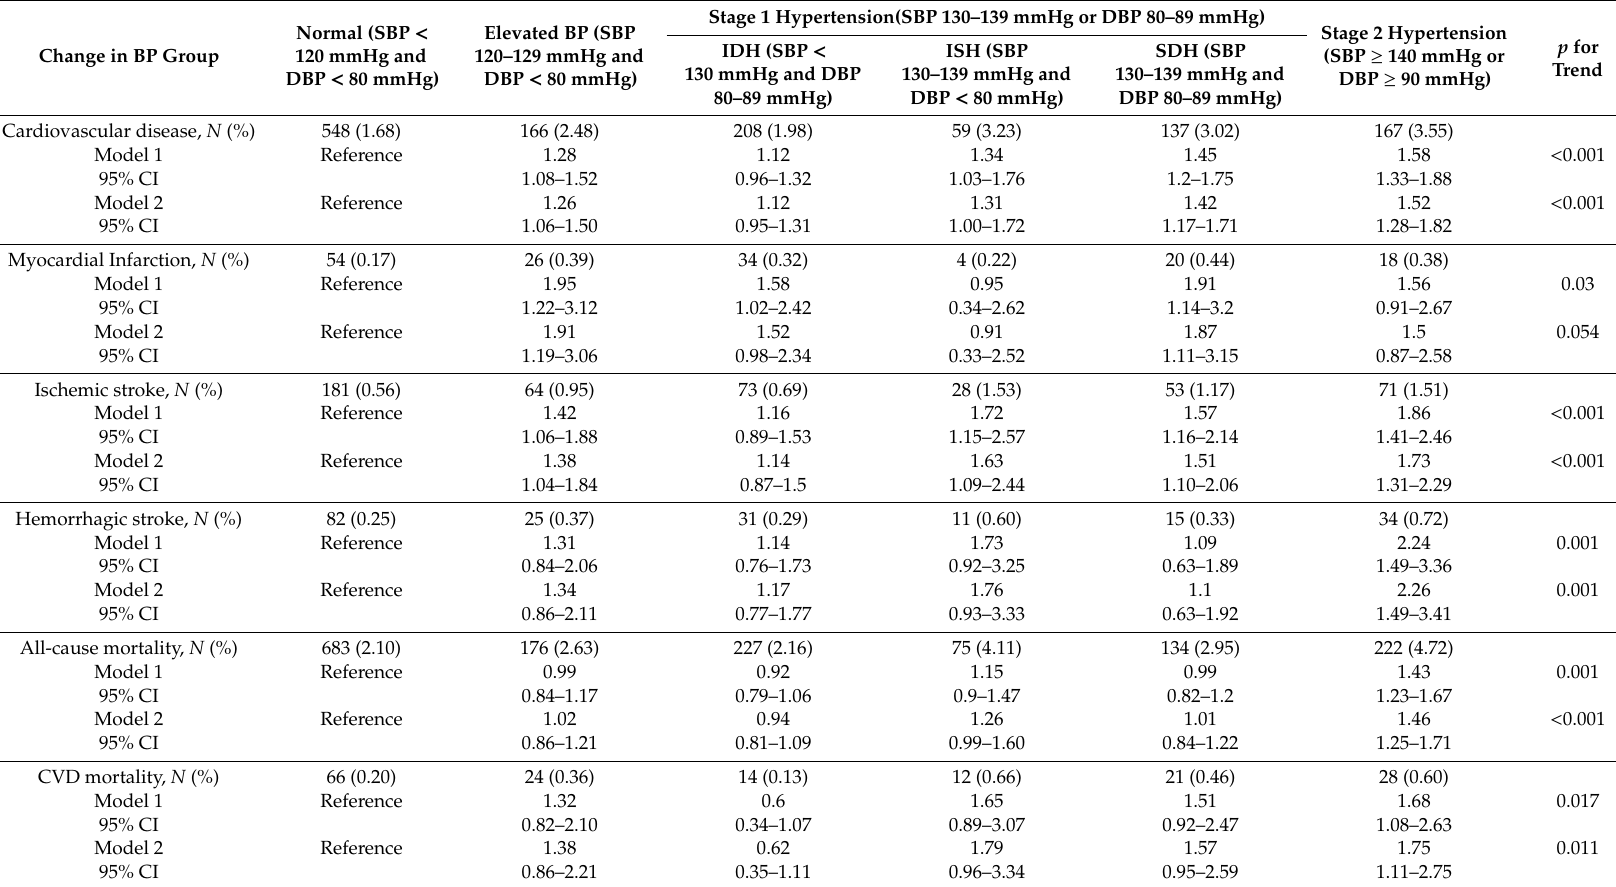
Table 3. Additional analysis of associations between change in blood pressure according to the 2017 ACC / AHA high blood pressure guideline and risk of cardiovascular disease, myocardial infarction, stroke, and